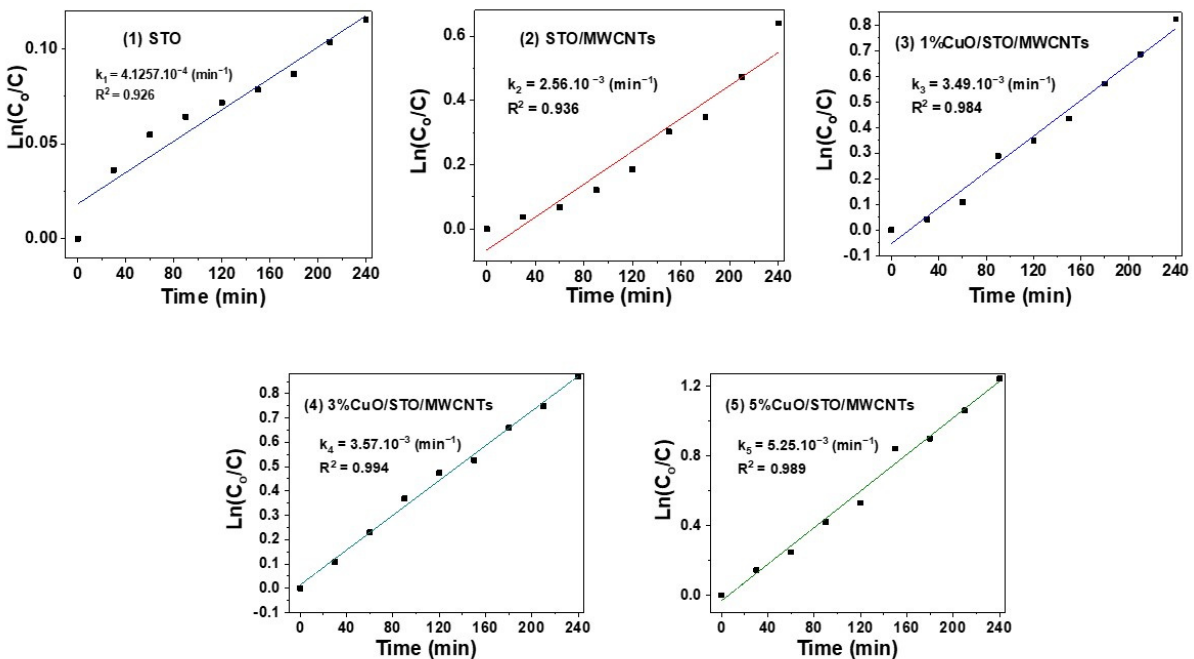
Figure 10. Effect of different catalysts on photocatalytic degradation of MB solution at different re- action times STO ( 1 ), STO/MWCNTs ( 2 ), 1% CuO/STO/MWCNTs ( 3 ), 3% CuO/STO/MWCNTs ( 4 ), 5% CuO/STO/MWCNTs ( 5 ).